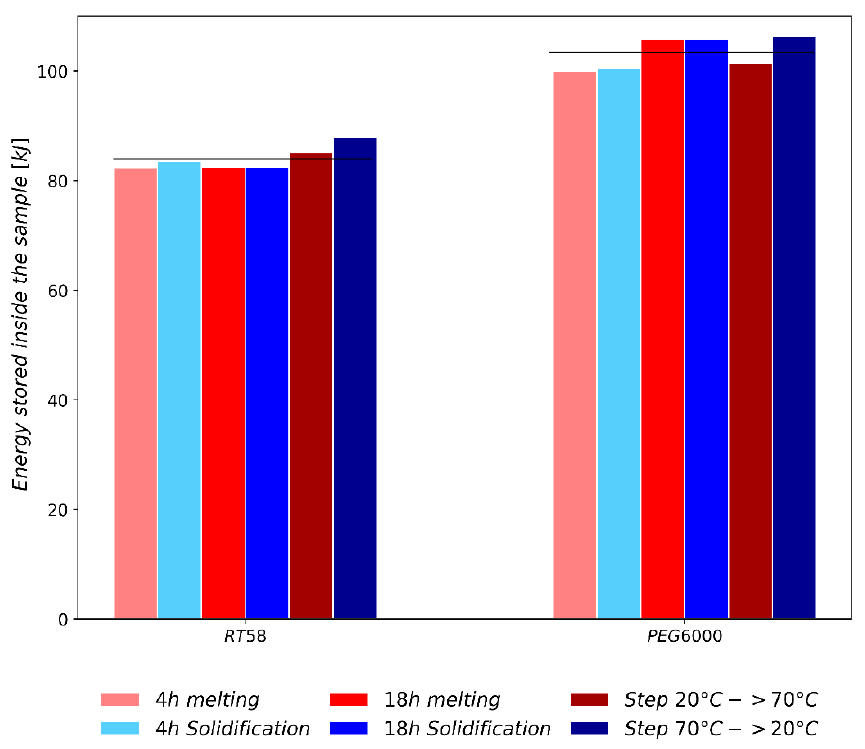
Figure 9. Comparison of the total energy stored between 20 °C and 70 °C inside the sample (PMMA brick + PCM) for the different thermal loads tested.